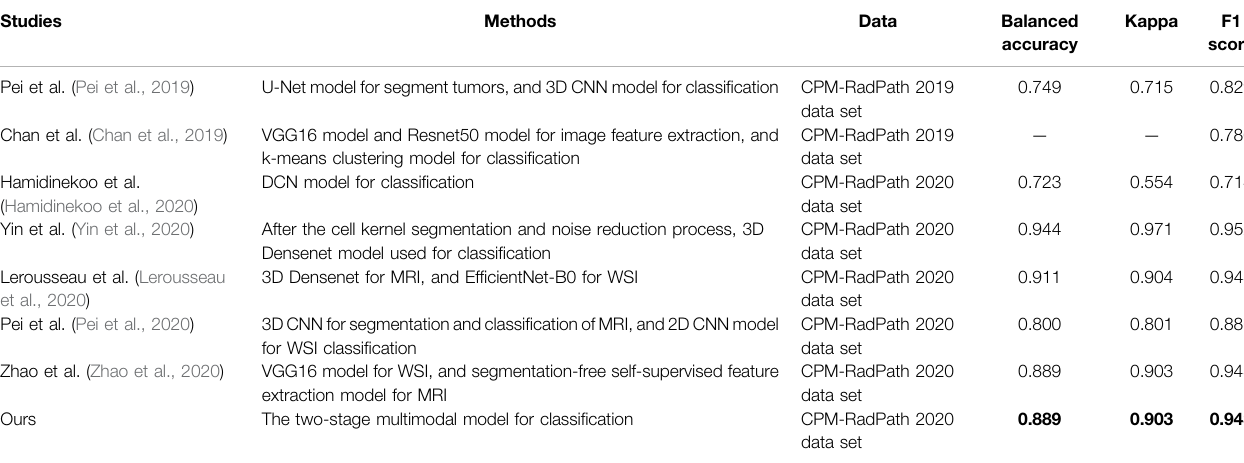
TABLE 4 | Comparison with related works on CPM-RadPath validation data.